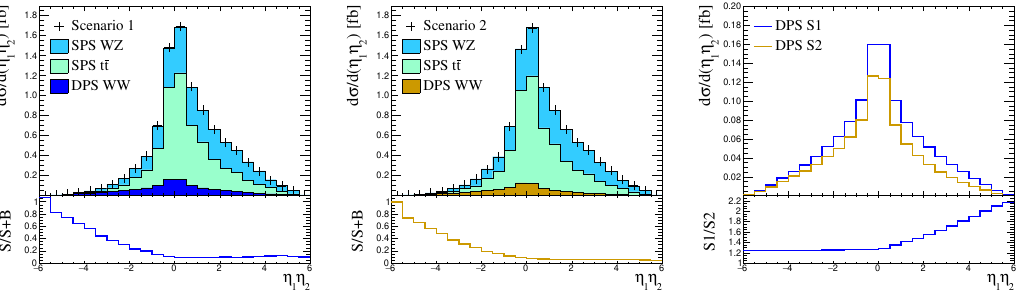
Figure 17 . Results of the template (cid:12)ts. Left: scenario 1: min-corr model (cid:12)tted to data with mix-pol DPS contribution. Middle: scenario 2: mix-pol model (cid:12)tted to data with min-corr DPS contribution. Right: the extracted DPS signals in the two scenarios (S1 and